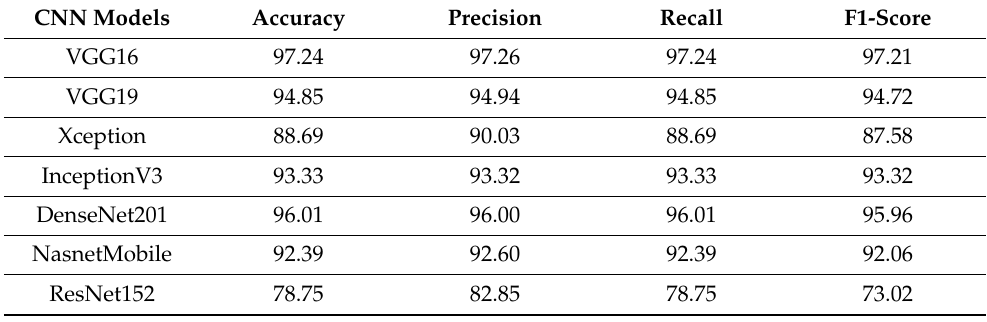
Table 2. Weighted average of performance metrics by different deep learning models for COVID-19 and normal classification.